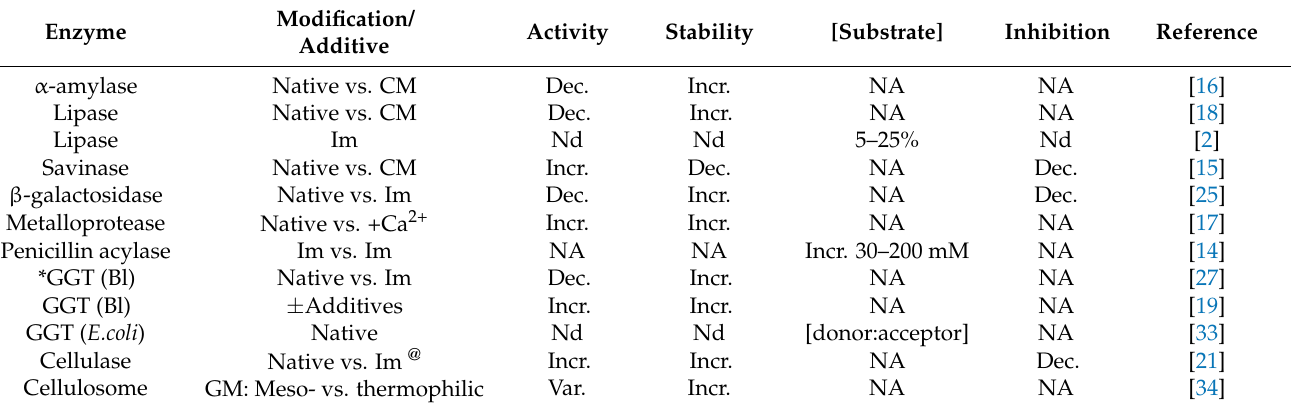
Table 2. Activity, stability, inhibition or substrate concentration: Basis for enhanced